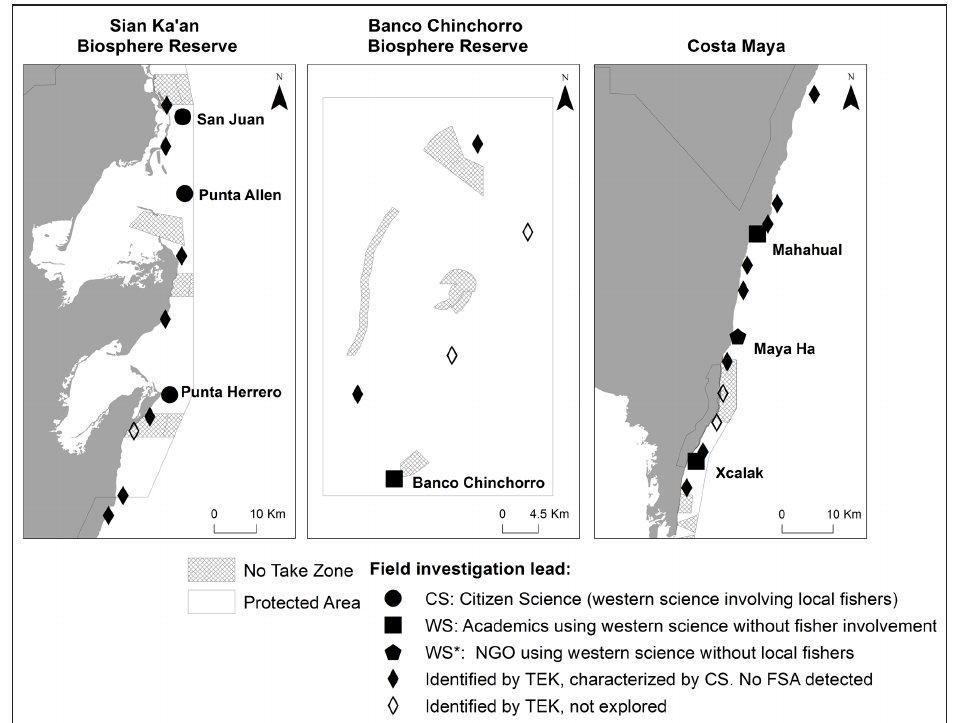
Figure 2: Location of documented FSA in the Mexican